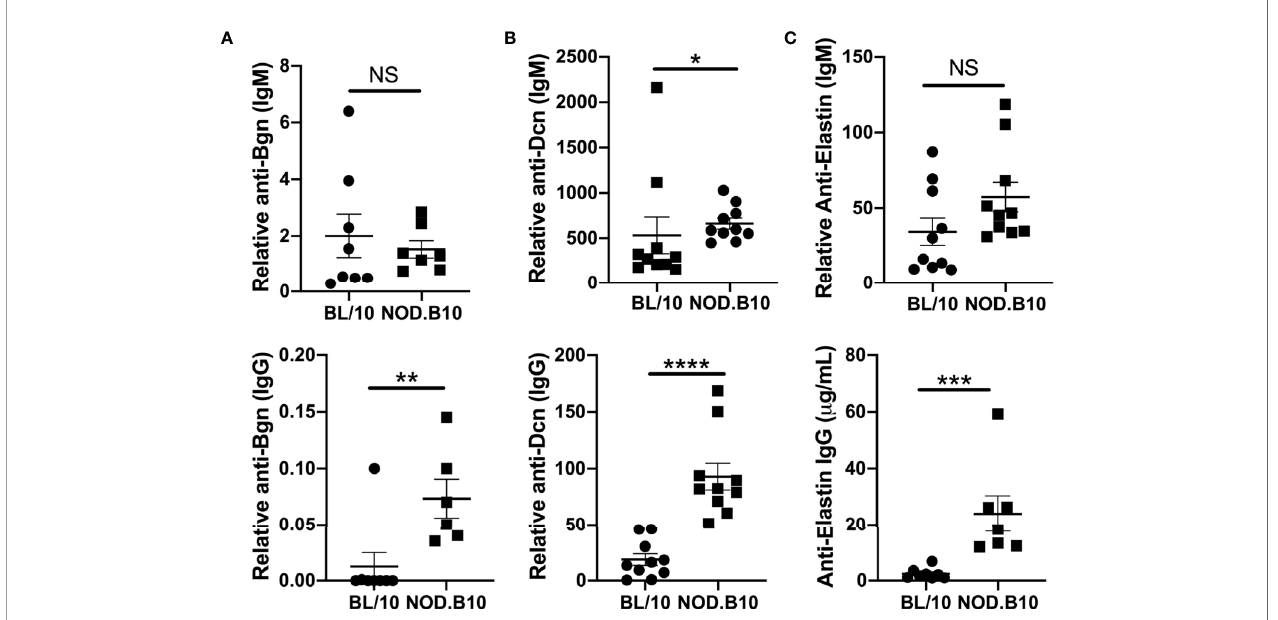
FIGURE 5 | NOD.B10 females exhibit elevated autoantibodies against ECM constituents. Sera were harvested from NOD.B10 and BL/10 mice (n = at least 7 each). ELISAs were performed for IgM and IgG autoantibodies directed against (A) Bgn, (B) Dcn and (C) Eln. Horizontal lines represent the mean and SEM, (NS, non- signi fi cant; *p < 0.05, **p < 0.01, ***p < 0.001, ****p <